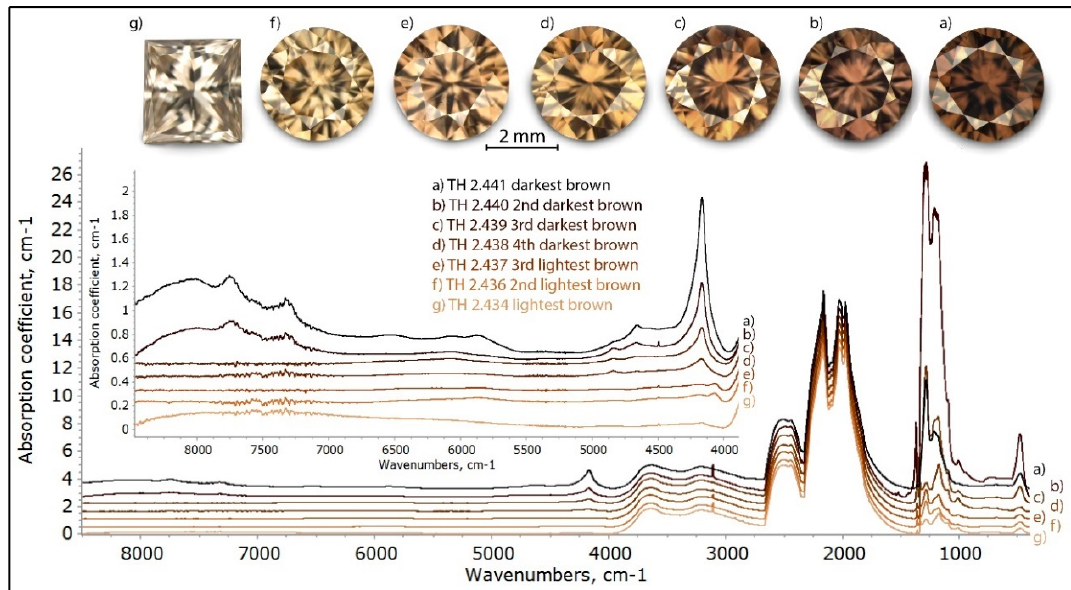
Figure 6. The normalized infrared spectra of a color suite of diamonds with a deformation-related brown color. It can be seen that in these type Ia diamonds, the intensity of the AC absorption correlates well with the darkness of the brown color; the lightest brown diamonds have the weakest AC while the darkest brown diamonds have the strongest AC absorption. The spectra were shifted vertically for clarity.